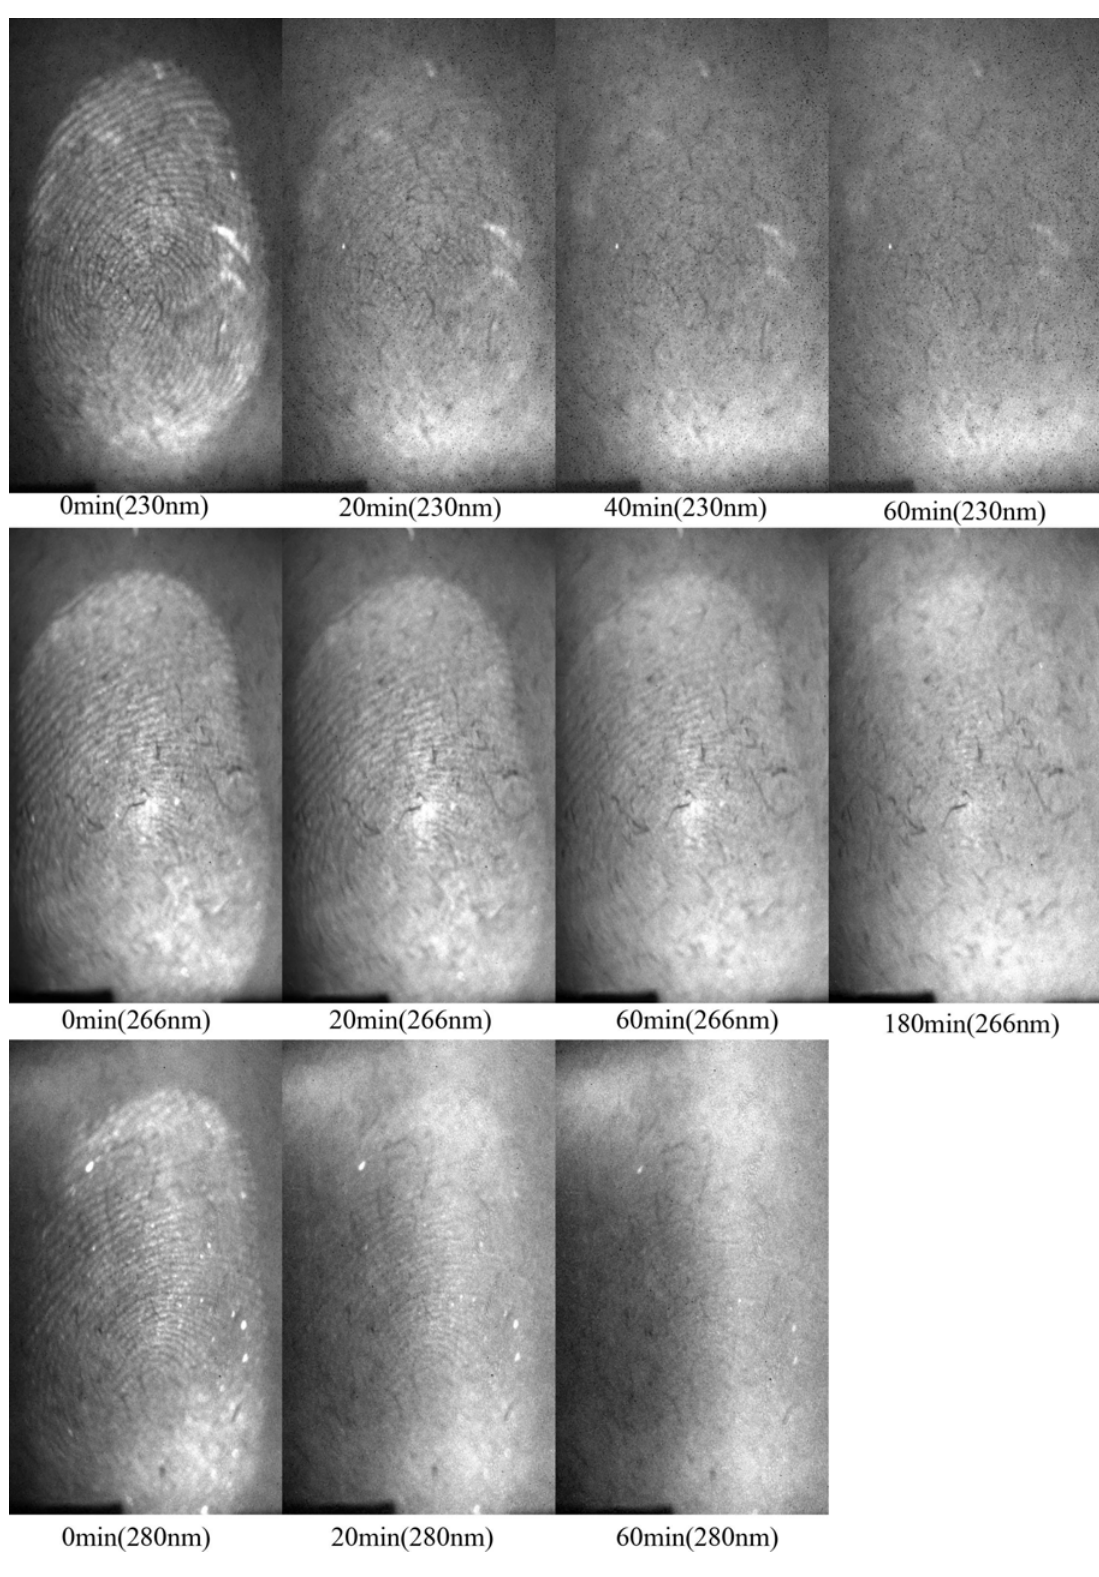
FIGURE 6. Time variation of fluorescence images of fingerprints on a HG white